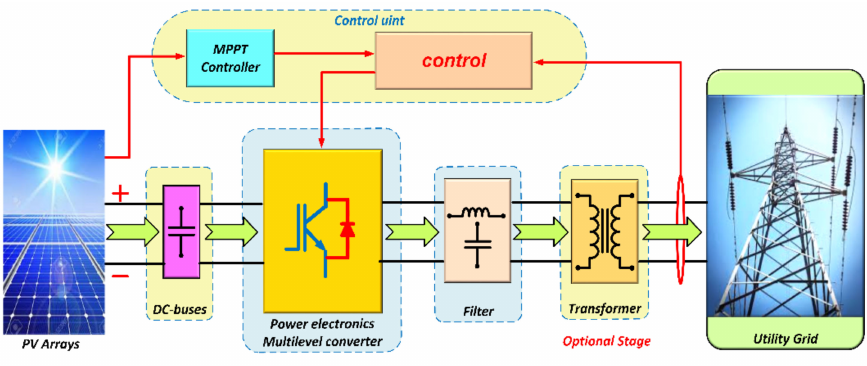
Figure 1. A photovoltaic (PV) system with power electronics and the needed